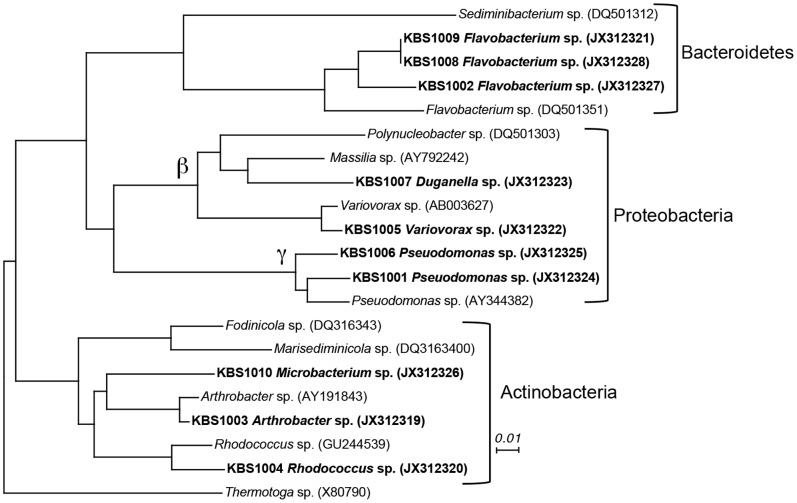
Heterotrophic bacteria grew on Super Hume.Phylogenetic relationship of bacteria cultivated on Super Hume as a sole carbon source (bold) along with reference sequences (non-bold). Trees were constructed from aligned 16S rRNA sequences using neighbor-joining methods. γ = γ-Proteobacteria and β = β-Proteobacteria. The scale bar represents the sequence dissimilarity. Thermotoga is an archaeon that was used as an outgroup.